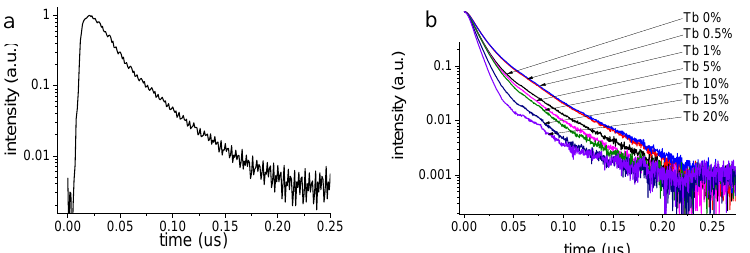
Fig. 2. Room temperature decay curves of the CeF 3 -YF 3 nanoparticles doped with (a) Eu 3+ (5%), (b) various amounts of Tb 3+ ions under 299 nm excitation.